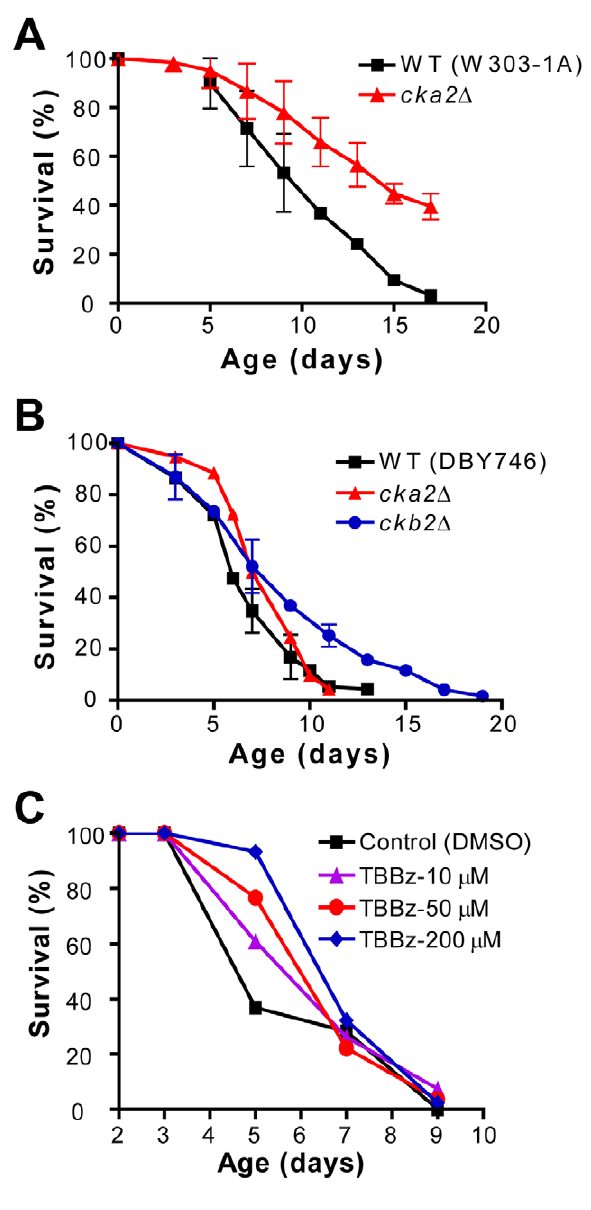
Figure 5. CK2 regulates life span in different genetic back- grounds. (A) CLS of wild type (W303-1A) and cka2 D . (B) CLS of DBY746 and of mutants lacking either Cka2 or Ckb2. (C) CLS of wild type DBY746 treated with increasing concentrations of TBBz (10–200 m M) at day 2 and 5. DMSO was used as a vehicle. (A,B) show an average of 2–3 experiments. A representative experiment is shown in (C). All the survival studies were performed leaving the yeast cultures in medium until the end of the